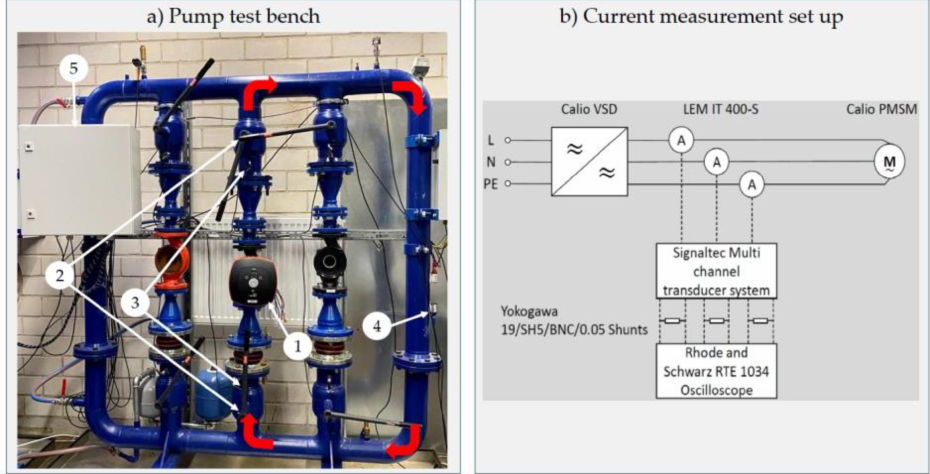
Figure 4. The experimental setup; ( a ) pump test bench; ( b ) current measurement